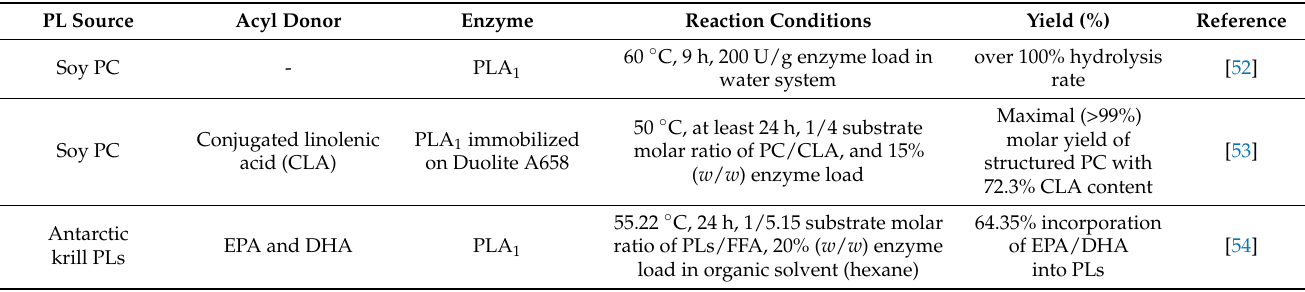
Table 3. PLA-mediated SPLs